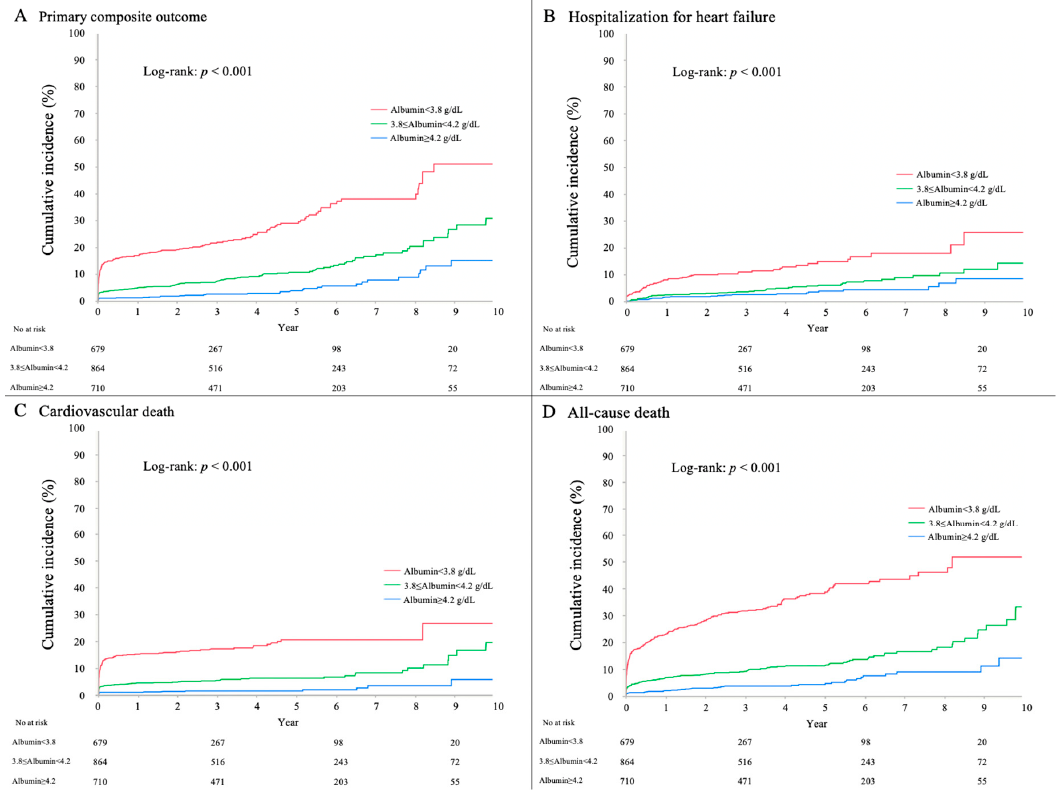
Figure 2. Primary and secondary outcomes. Kaplan-Meier curves show the incidence of primary composite outcome ( A ), hospitalization for heart failure ( B ), cardiovascular death ( C ), and all-cause death ( D ).